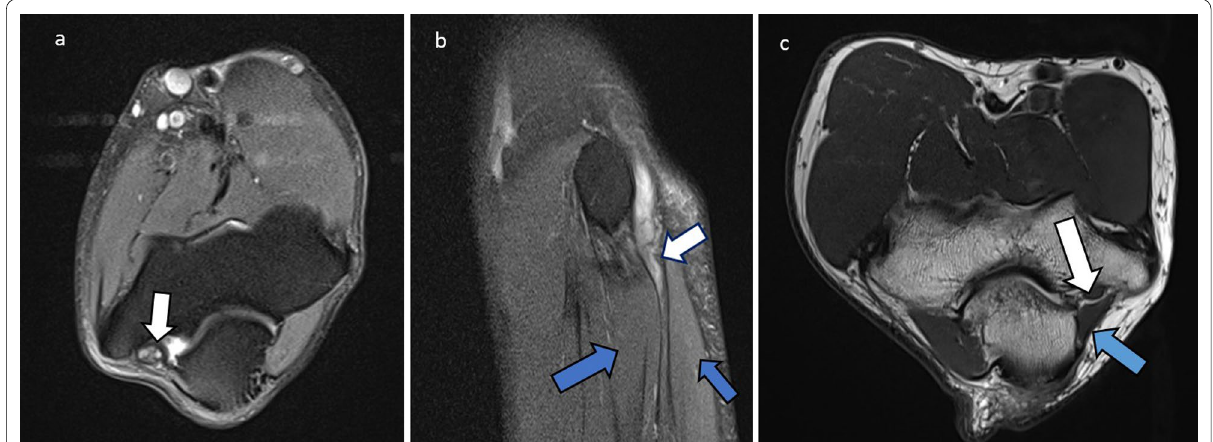
ulnar nerve (white arrow) returns increased signal intensity at the level of the cubital tunnel and is focally enlarged. b Sagittal PDFS elbow of a 54-year-old male with ulnar neuropathy. The ulnar nerve is enlarged (white arrow), with compression as it enters between the two flexor carpi ulnaris heads (blue arrows). c Axial PD elbow of a 60-year-old male showing the normal variant anconeus epitrochlearis (blue arrow) superficial to the ulnar nerve (white arrow) at the cubital tunnel. This can predispose to ulnar nerve entrapment